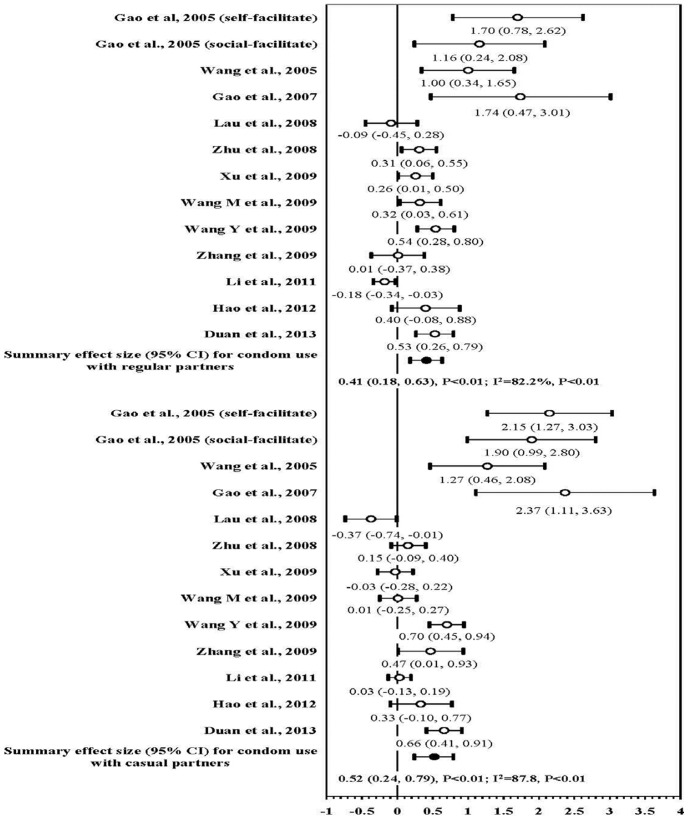
Forest plot of effect size: the impact of behavioral interventions on consistent condom use during anal intercourses among MSM in China by types of sexual partners.